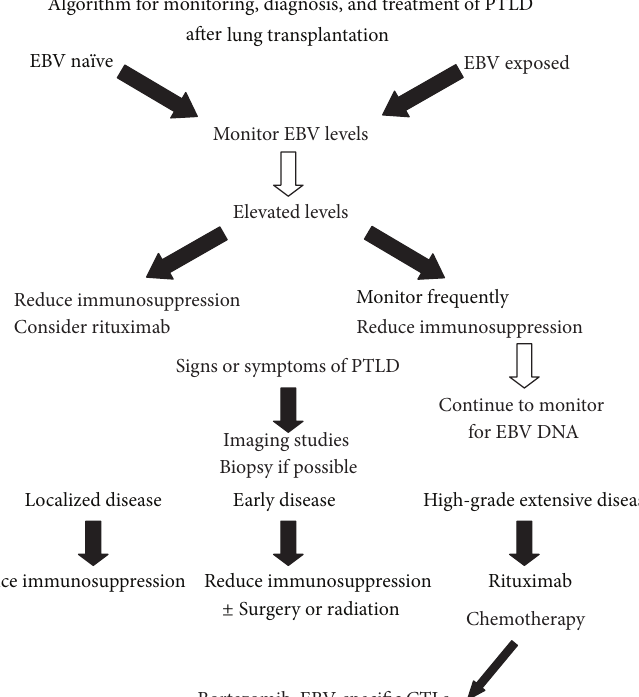
Figure 2: This algorithm proposes routine surveillance of high-risk patients to enable diagnosis at an early stage. Starting with EBV viral load monitoring, patients who manifest elevated levels with symptoms would progress to imaging studies and biopsy of enlarged lymph nodes or nodules. Identification of CD20 lesion positivity, cytogenetics, immunostaining for LMP and EBER, and assessment of monoclonal or polyclonal proliferation can focus further therapy. In localized disease, reduction of immunosuppression or surgery may be sufficient to control disease, while rituximab may be given concurrently. High-grade extensive disease may require chemotherapy, bortezomib, or EBV- specific cytotoxic T lymphocytes if available. From